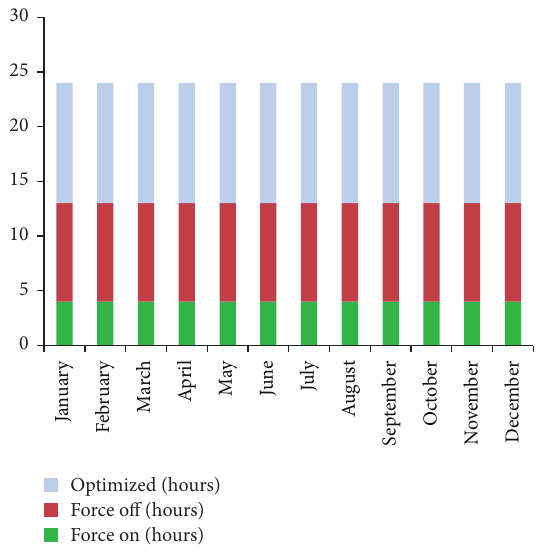
Figure 5: Generator operation schedule chart for diesel generator